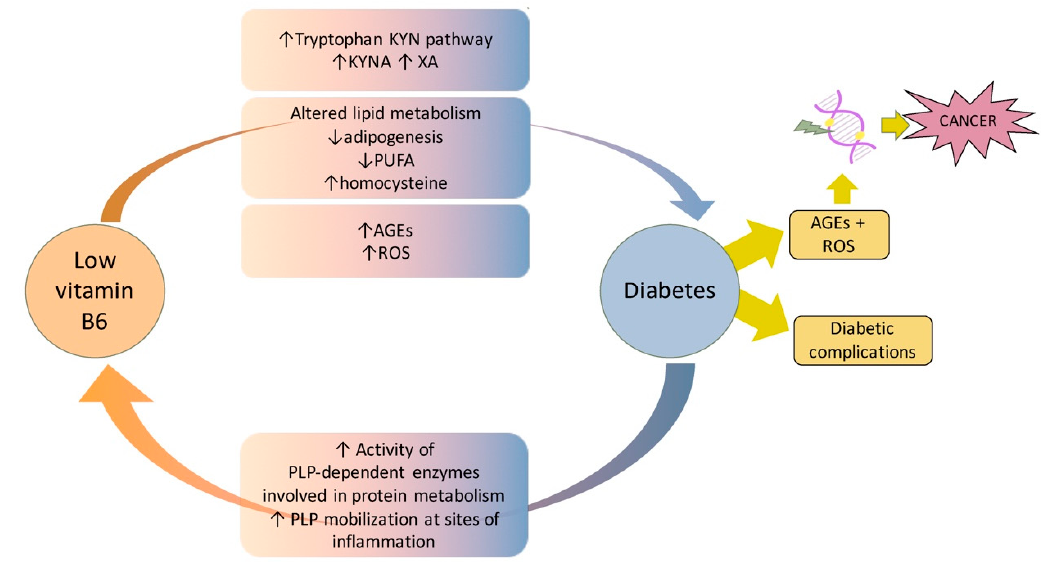
Figure 3. Summary of main mechanisms and pathways at the basis of the association between vitamin B6 and diabetes, inferred from the studies reported in the main text.